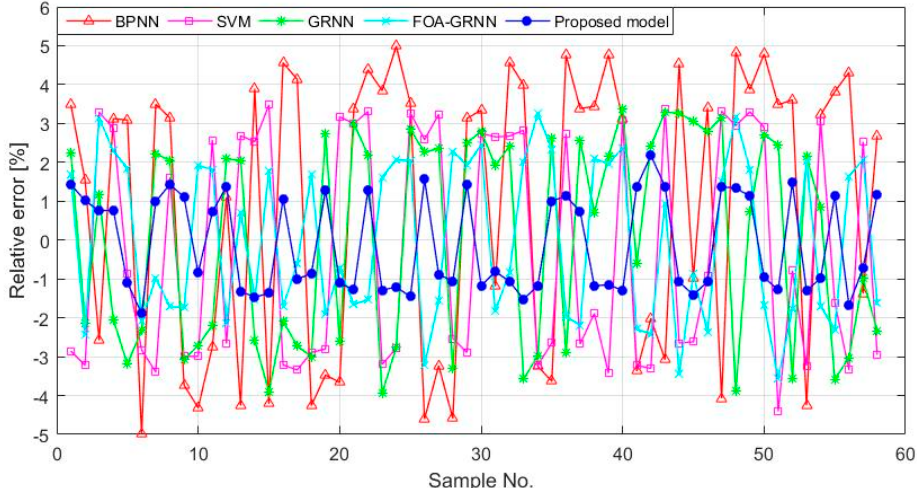
Figure 7. The relative error curve of each method.